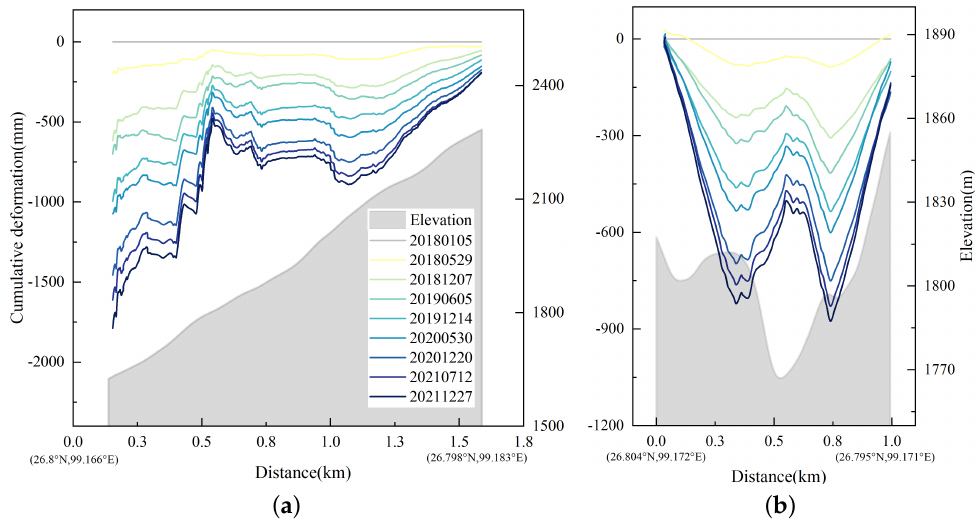
Figure 9. Time − series cumulative deformation of profiles. ( a ) Profile A. ( b ) Profile B. The solid lines represent cumulative deformation from 5 January 2018, until the date, corresponding to the left vertical axis; and the dotted lines represent the average annual deformation rate of points on the profile lines, corresponding to the right vertical axis. The grey parts represent the elevation of the